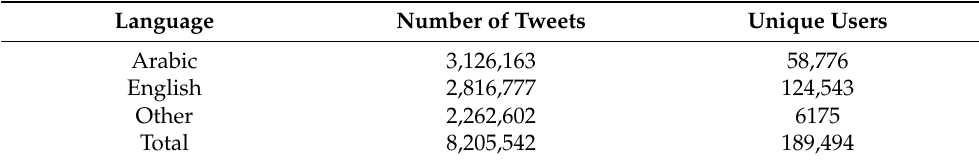
Table 1. Breakdown of language use and unique users from the United Arab Emirates (UAE) Twitter dataset for